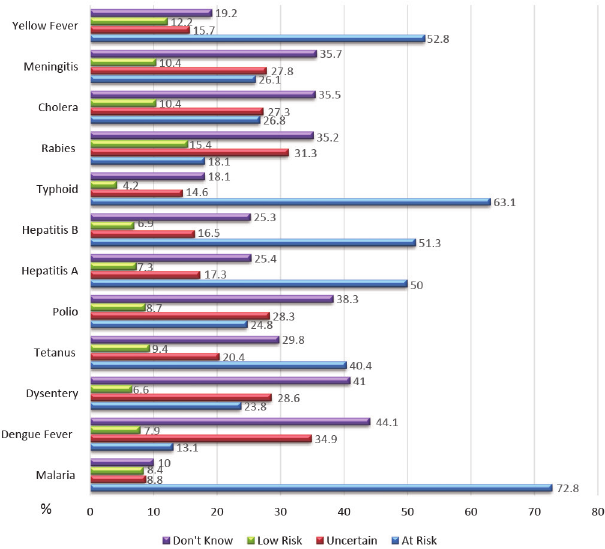
Figure 1. Perceived Risk of Travel-Related Diseases Among the Surveyed